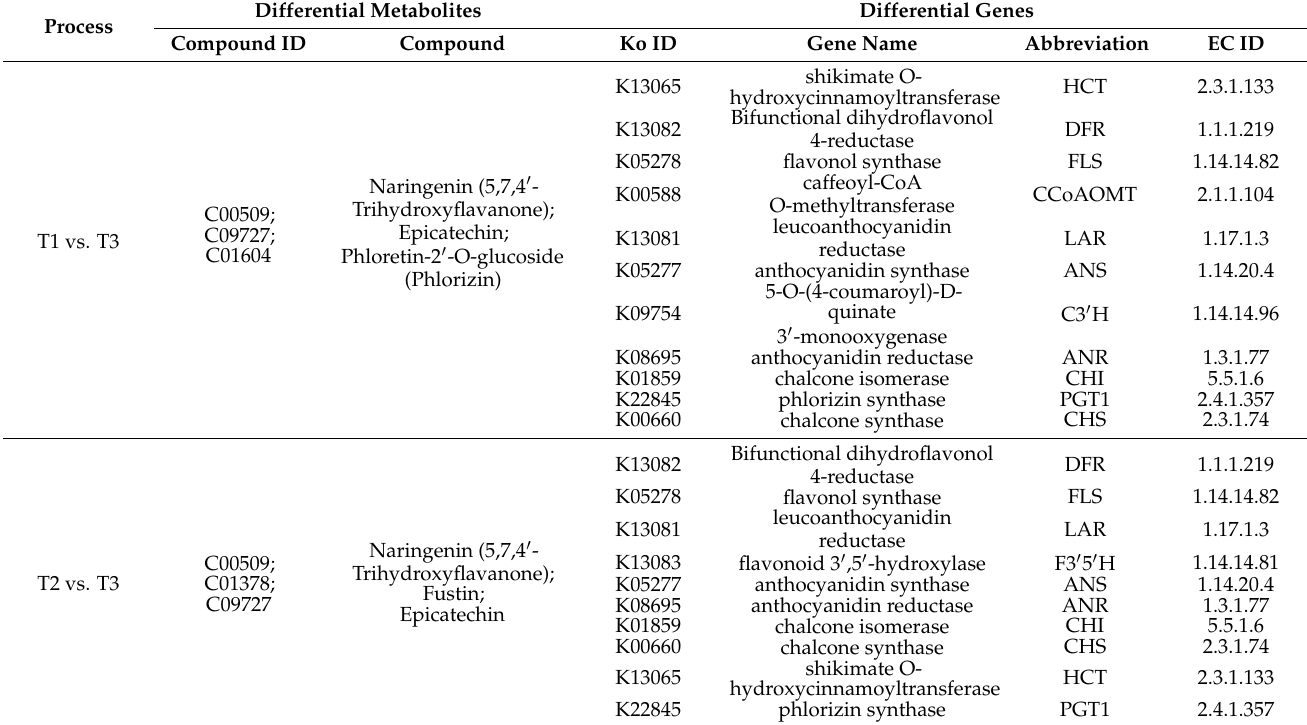
Table 2. Differential metabolites and genes in anthocyanin biosynthesis pathway.